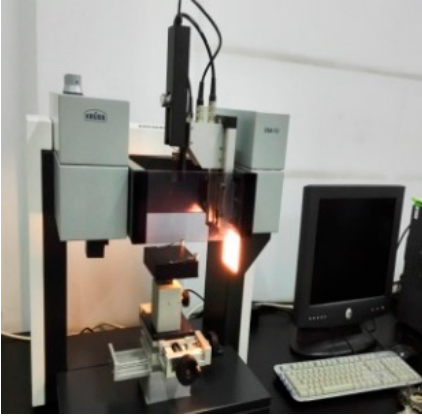
Figure 4. DSA100 type drop shape analyzer.